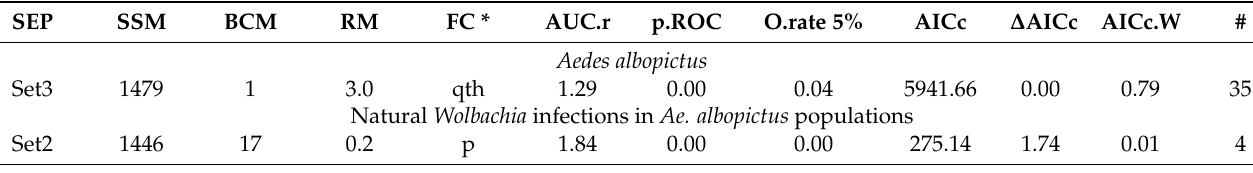
Table 1. Model performance under optimal parameters using sets of environmental predictors (SEP), statistically significant models (SSM), best candidate models (BCM), regularization multiplier (RM), features classes (FC), mean Area Under the Curve ratio (AUC.r), partial Receiver Operating Characteristic (p.ROC), omission rate 5% (O.rate 5%), Akaike information criterion corrected (AICc), delta Akaike information criterion corrected ( ∆ AICc), Akaike information criterion corrected weight (AICc.W), number of parameters (#; summarizes the combination of environmental variables, multiple regular- izations, and features other than 0 that provide information for the construction of the model based on lambdas), and candidate sets of environmental variables tested during calibration of the Aedes albopictus model in M é xico. * q = quadratic; t = threshold; h = hinge; p = product.